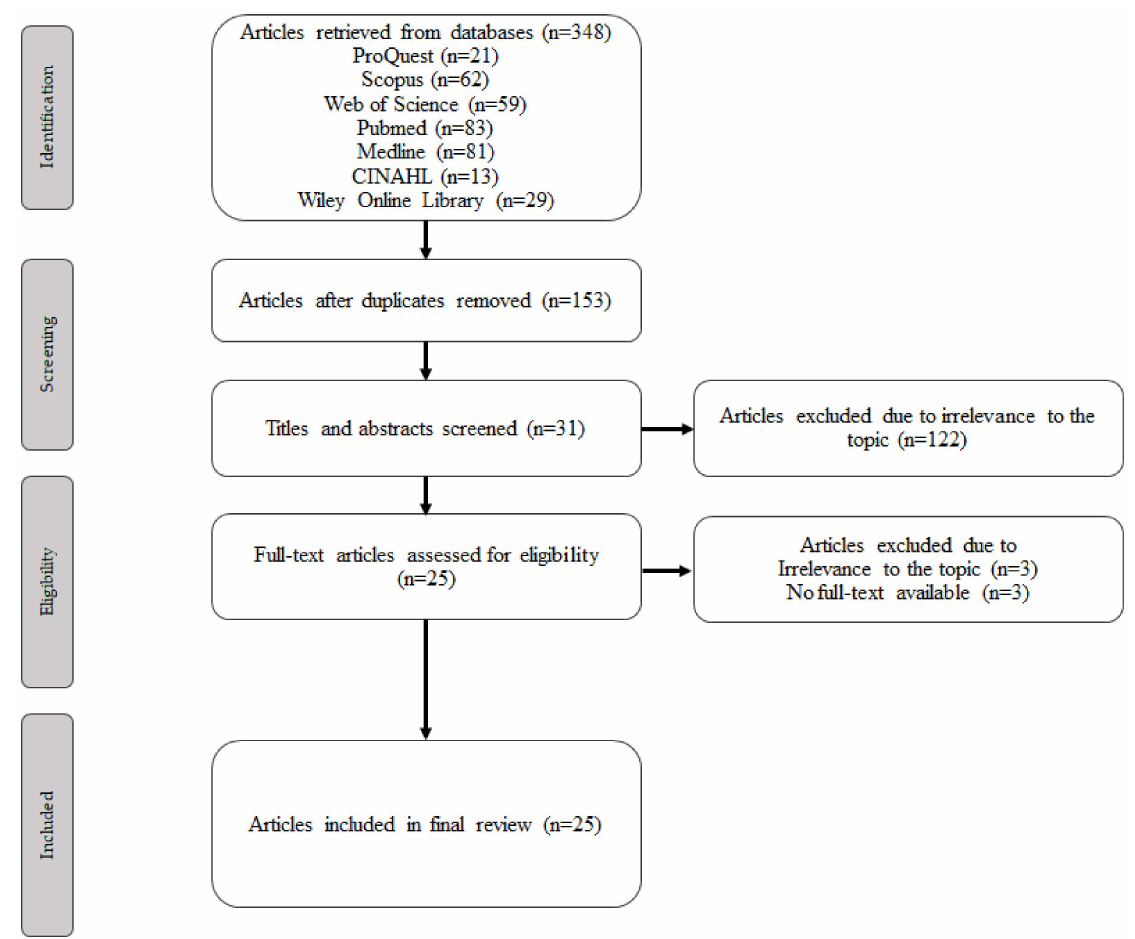
Figure 1. Flow chart showing search strategy to identify eligible